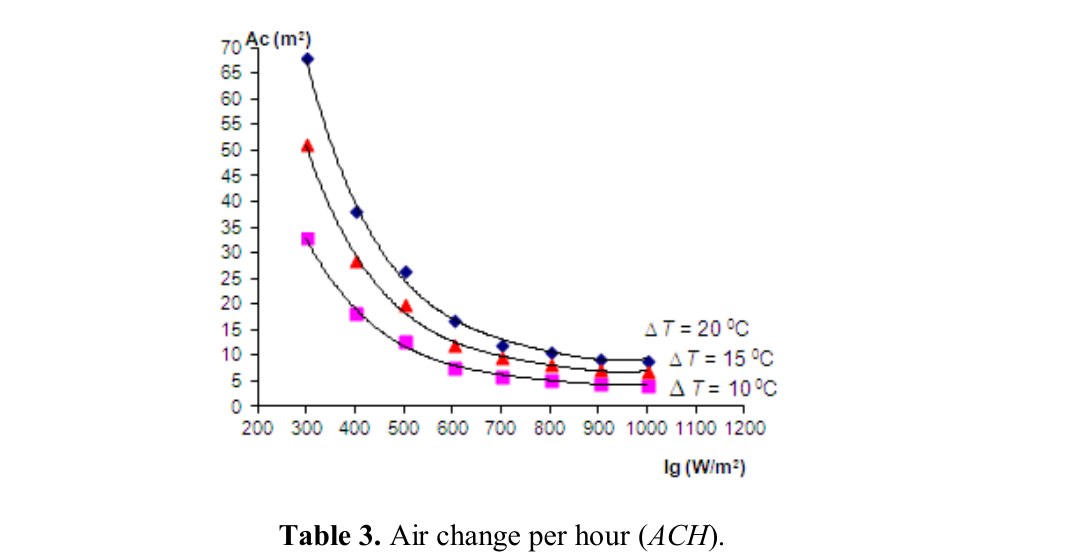
Figure 9. Area of solar air colectors versus solar radiation for three fields of temperature for an office building.